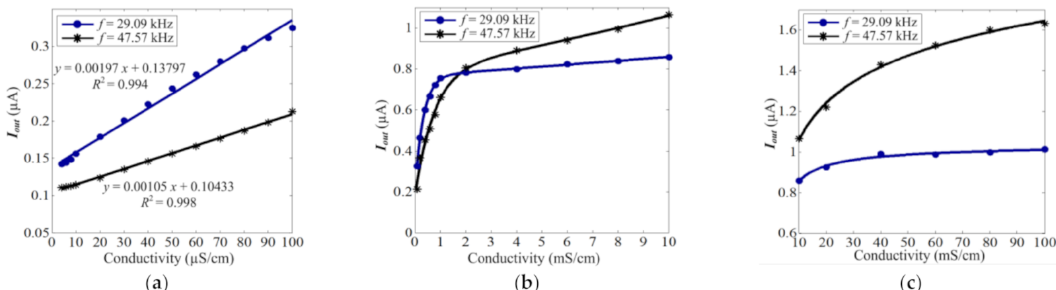
Figure 7. The input-output characteristics of the new C 4 D sensor for conductivity measurement with the working frequency of 29.09 and 47.57 kHz. ( a ) The detailed input-output characteristics under the conductivity range of 1–100 µ S/cm. ( b ) The detailed input-output characteristics under the conductivity range of 100 µ S/cm–10 mS/cm. ( c ) The detailed input-output characteristics under the conductivity range of 10–100 mS/cm.